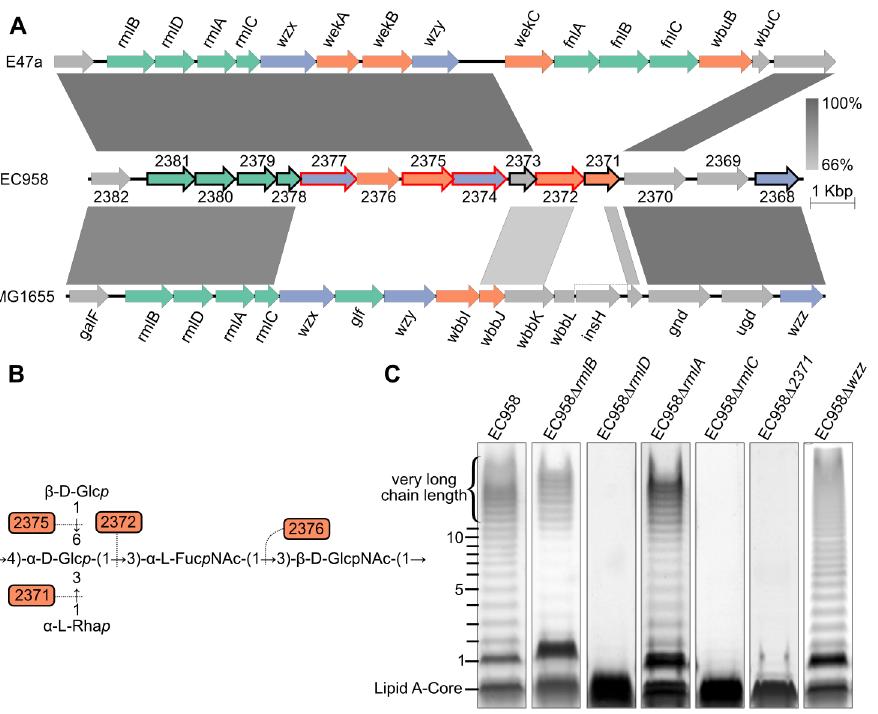
Figure 5. Characterization of O25b antigen genes in EC958. (A) Comparison of the O-antigen cluster in EC958 with MG1655 (NC_000913) and E47a (GU014554); genes in green are involved in sugar biosynthesis, genes in purple are involved in O-antigen processing and genes in orange encode glycosyl transferase enzymes; genes with a black outline were shown to be required for serum resistance and genes with a red outline were defined as essential. (B) Predicted function of the four glycosyl transferases in the biosynthesis of the O25b repeat unit [57,58]. (C) LPS gels showing changes in O-antigen structures corresponding to mutations in each gene.